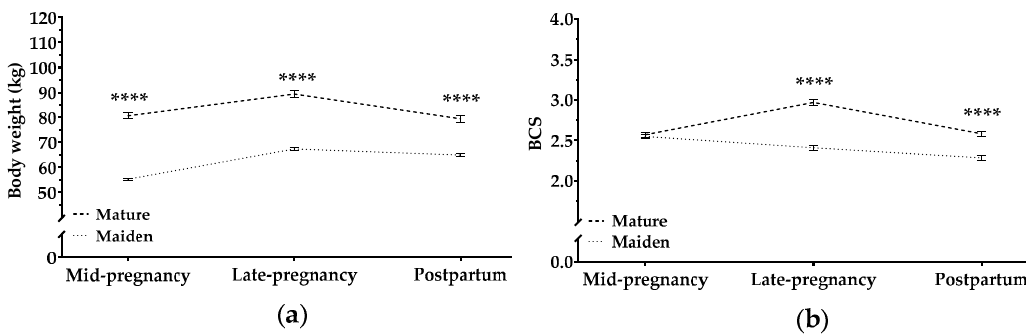
Figure 3. Body weight (kg) ( a ) and body condition score (BCS) ( b ) in mature ewes (dashed line) and in maiden sheep (dotted lines) throughout the study period. Data are mean ± S.E.M. Time × age-group interaction was significant ( p < 0.0001). Asterisks indicate significant differences between age groups at each time point (**** p < 0.0001).